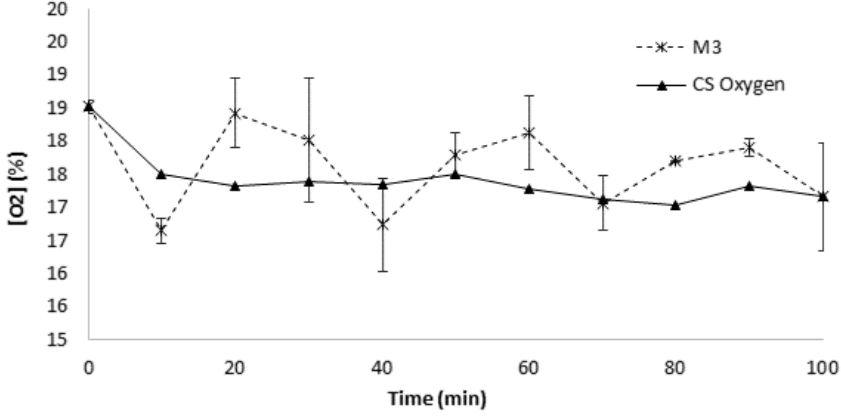
Figure 7. Dynamic respirometry profiles.